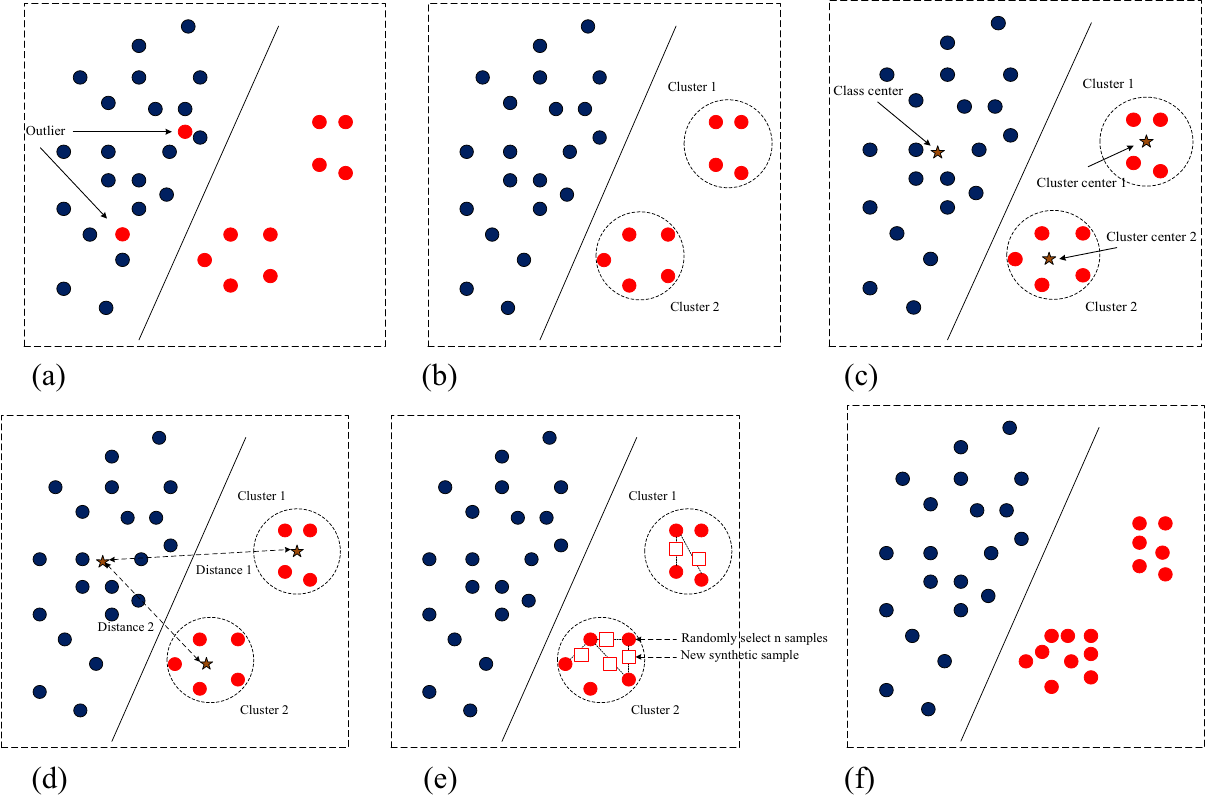
Figure 2. Simulation process of SD-KMSMOTE method. ( a ) Original dataset; ( b ) Filtering isolated sample points and generating clusters; ( c ) Calculating the majority class centres and the cluster centres of each cluster of the minority class; ( d ) Calculating the distance of each cluster to class M; ( e ) Synthesizing new samples; ( f ) The obtained balanced